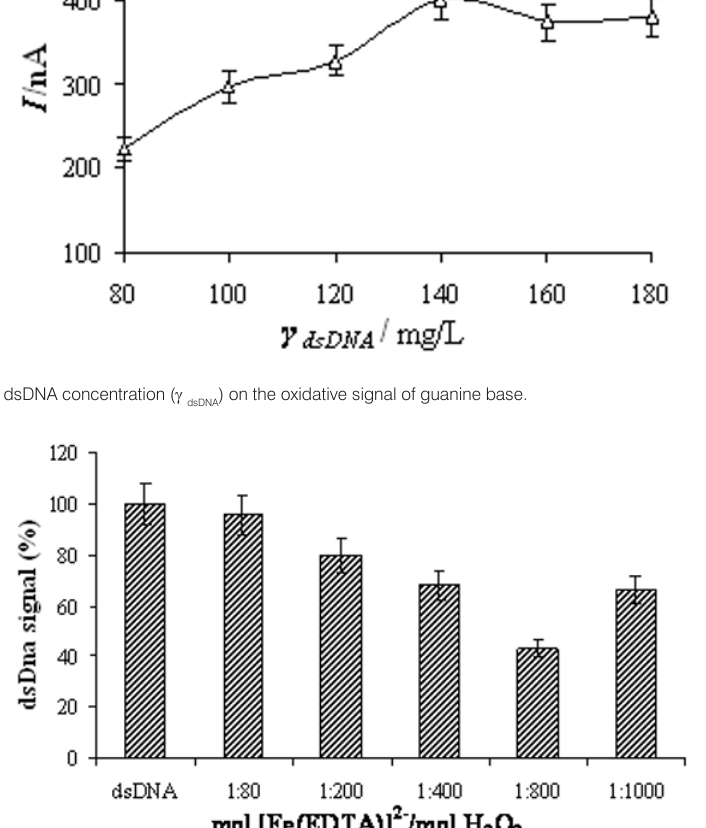
Figure 5. Evaluation of deep dsDNA oxidative damage by Fenton’s cleavage